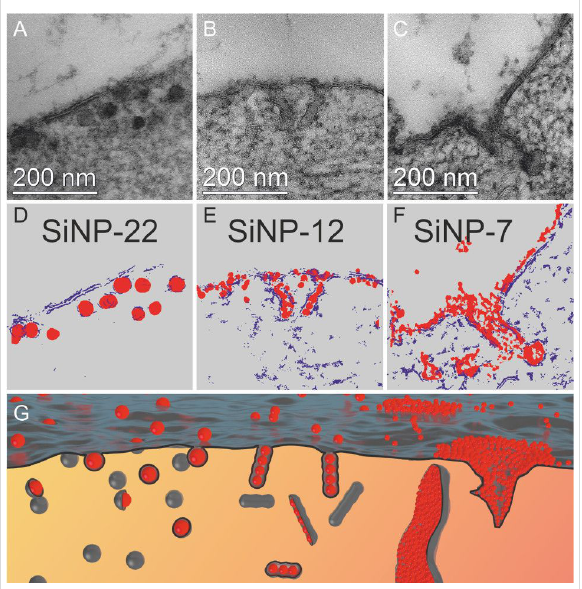
Figure 4: TEM brightfiled micrographs of high-pressure frozen HeLa cells exposed to SiNPs at a concentration of c = 75 µg·mL − 1 for 10 min, stained with OsO 4 and uranyl acetate (micrographs A–C show SiNP-22, SiNP-12 and SiNP-7, respectively). For clarification purpose the illustrations in D,E represent the membrane (blue) and the SiNPs (red) as extracted from energy filtered TEM measurements of the above micrographs. Schematic representation of the membrane–parti- cle interaction morphology (G) observed for the different particle sizes.